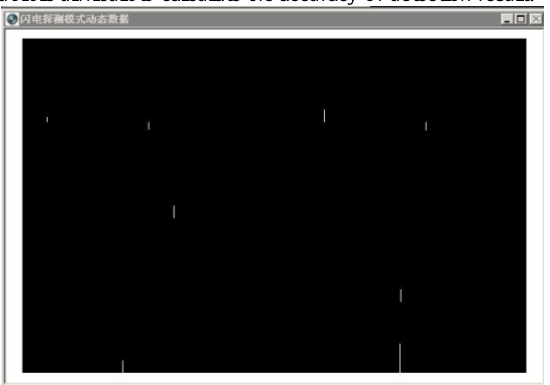
Figure12. The result of ground image acquisition system The detection rate of the lightning detection system can be obtained by dividing the number of lightning events correctly by the number of all lightning events in the sample. The detection rate of this system is 60%~95%. It is difficult to detect the weak lightning signal in daytime because of the influence of the noise of shrapnel. The detection rate can be improved by using lower threshold value.